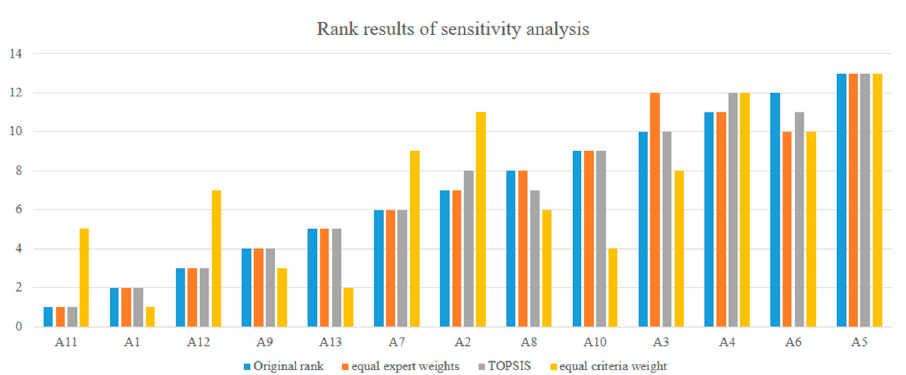
Figure 9. Ranking results of the sensitivity analysis.